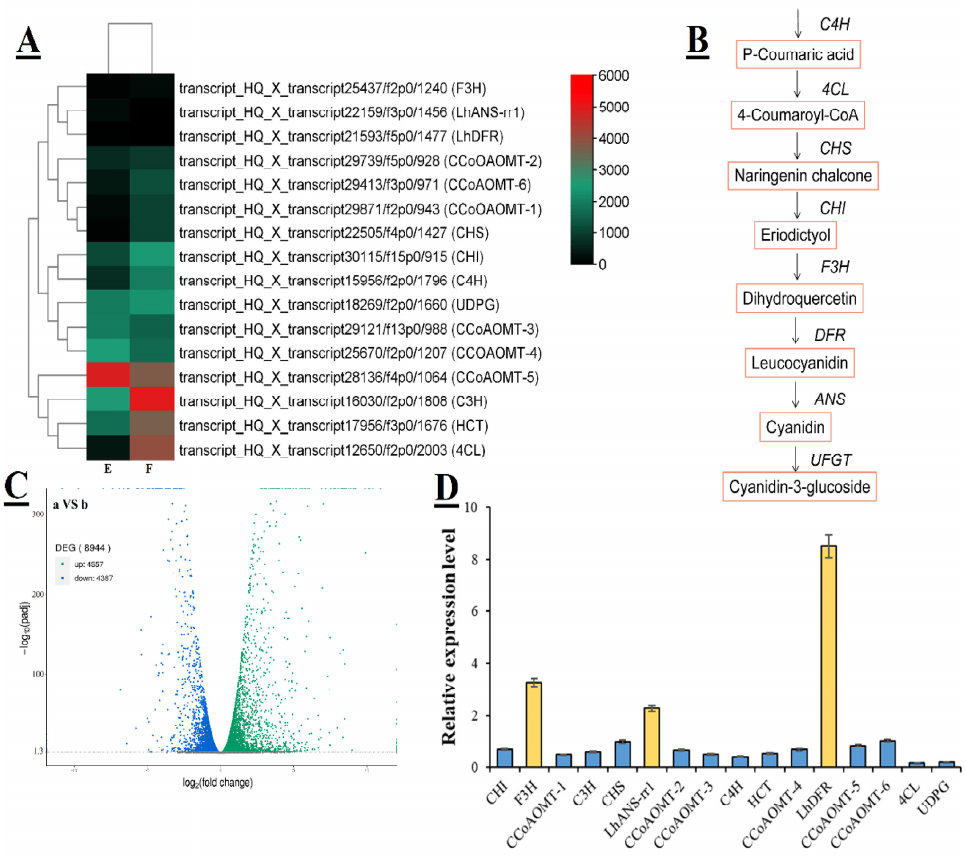
Figure 3. Transcriptome analysis and qRT-PCR validation of the candidate DEGs involved in an- thocyanin biosynthesis in Lilium ′ Siberia ′ . ( A ) A heatmap showing the expression patterns of DEGs involved in anthocyanin biosynthesis. The heatmap was generated based on the normalized log 2 (FoldChange) > 1 values for each DEG. Green and red scales represent relatively low or high expression, respectively. ( B ) Schematic diagram of metabolic pathway for cyanidin. ( C ) Volcano plot of the total differentially expressed genes in both E and F groups using the threshold of p < 0.05 and |log2FoldChange| > 1. The x -axis represents the log 2 (fold change) values for gene expression, and the y -axis represents the − log 10 ( p value). ( D ) The qRT − PCR validation of the DEGs involved in anthocyanin biosynthesis. Expression data are the represent as the mean values of three biological replicates ± SD. Yellow color represents significant up-regulation of genes, while blue color repre- sents insignificant changes. 3.3. MYB Gene and Cluster Analysis Based on full-length transcriptomics, 28 kinds of TFs were enriched, such as C3H , MYB-ralated , C2H2 , bHLH , GRAS , FAR1, and AP2 / EFF-ERF , etc. Among them, MYB and bHLH were mainly involved in anthocyanin biosynthesis. The number of MYBs reached 33, and bHLH reached 54 (Figure 4A). We finally selected the MYB transcription factor as the research object, which was the largest one related to anthocyanin synthesis. The results